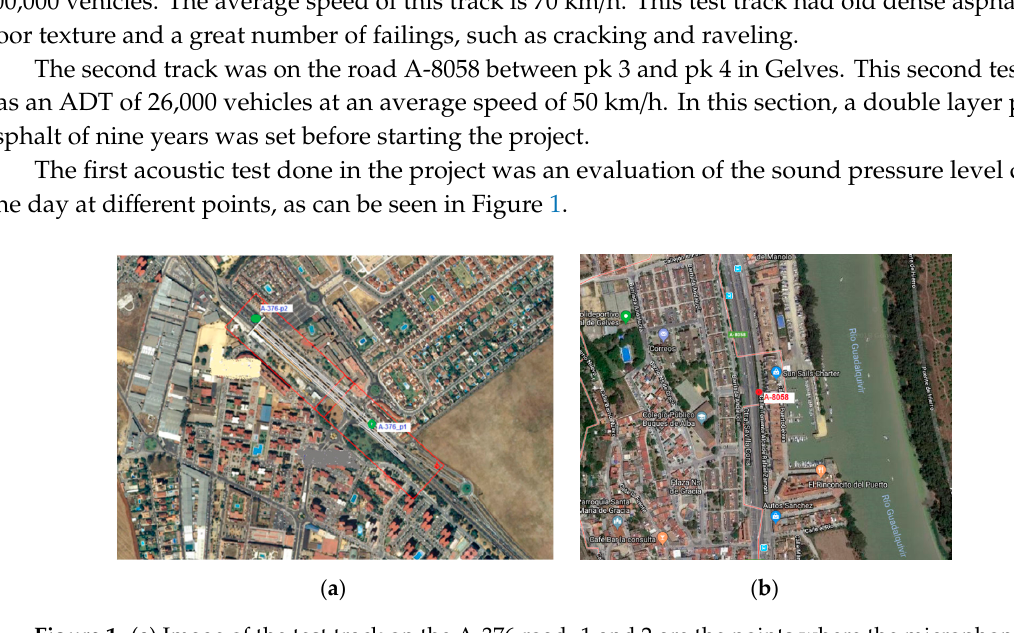
Figure 1. ( a ) Image of the test track on the A-376 road. 1 and 2 are the points where the microphones have been placed. ( b ) Image of the test track on the A-8058 road. The sound pressure equivalent levels for different day periods were calculated, and they are presented in the Table 1.